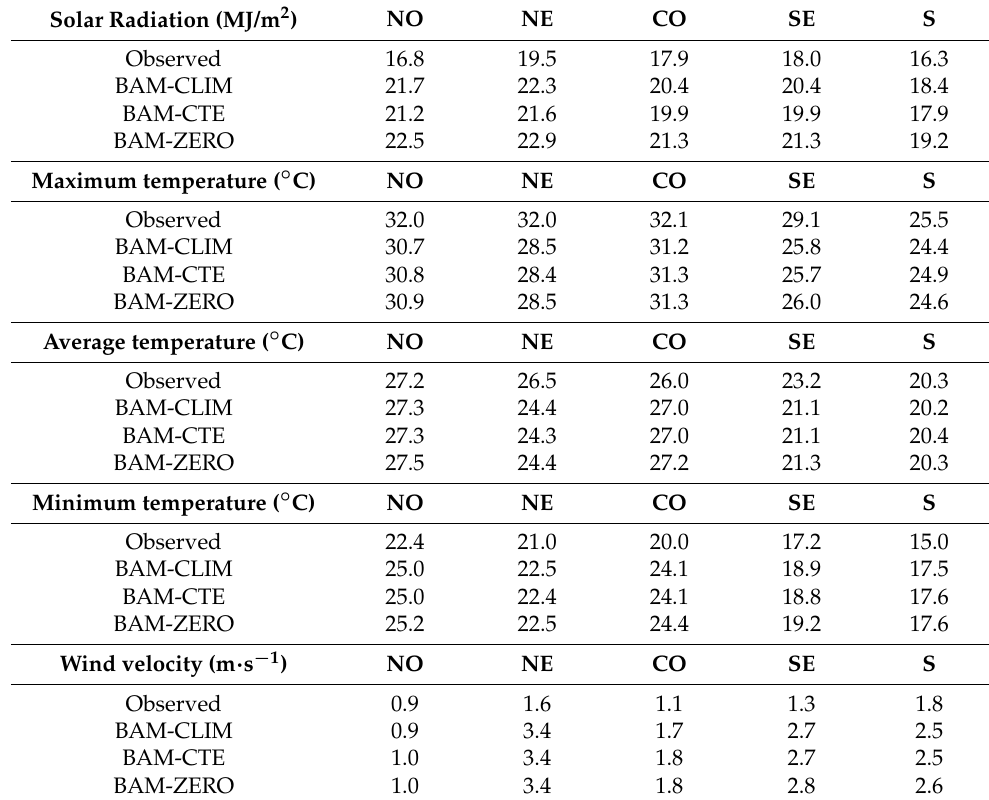
Table 2. Average values per region (north—NO, northeast—NE, mid-west—CO, southeast—SE, and south—S) of solar radiation (MJ/m 2 ), temperature ( ◦ C), and wind speed (m · s − 1 ) observed and with BAM for three different experiments of aerosol